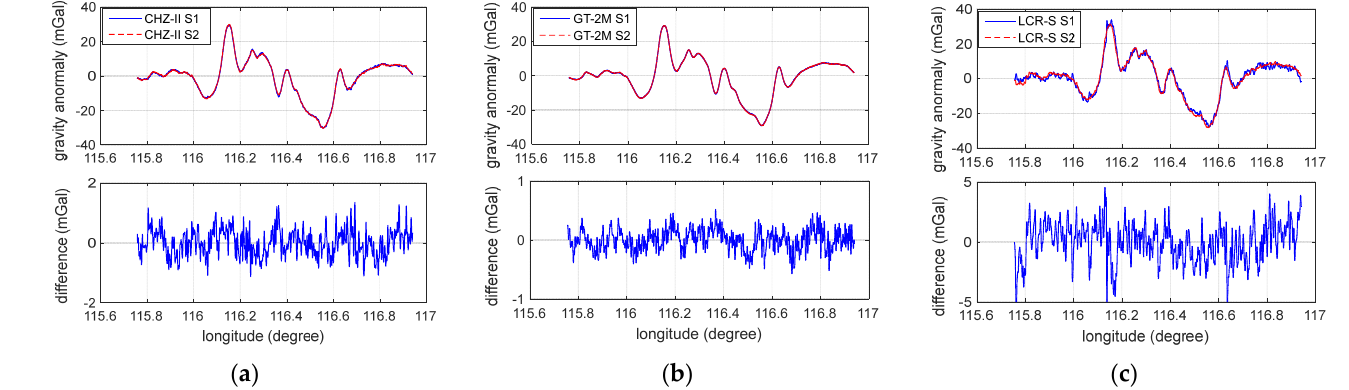
Figure 5. The gravity values and the mutual differences of the three instruments on the S1 and S2 survey lines after applying the calibrated parameters: ( a ) CHZ-II; ( b ) GT-2M; ( c ) LCR-S.